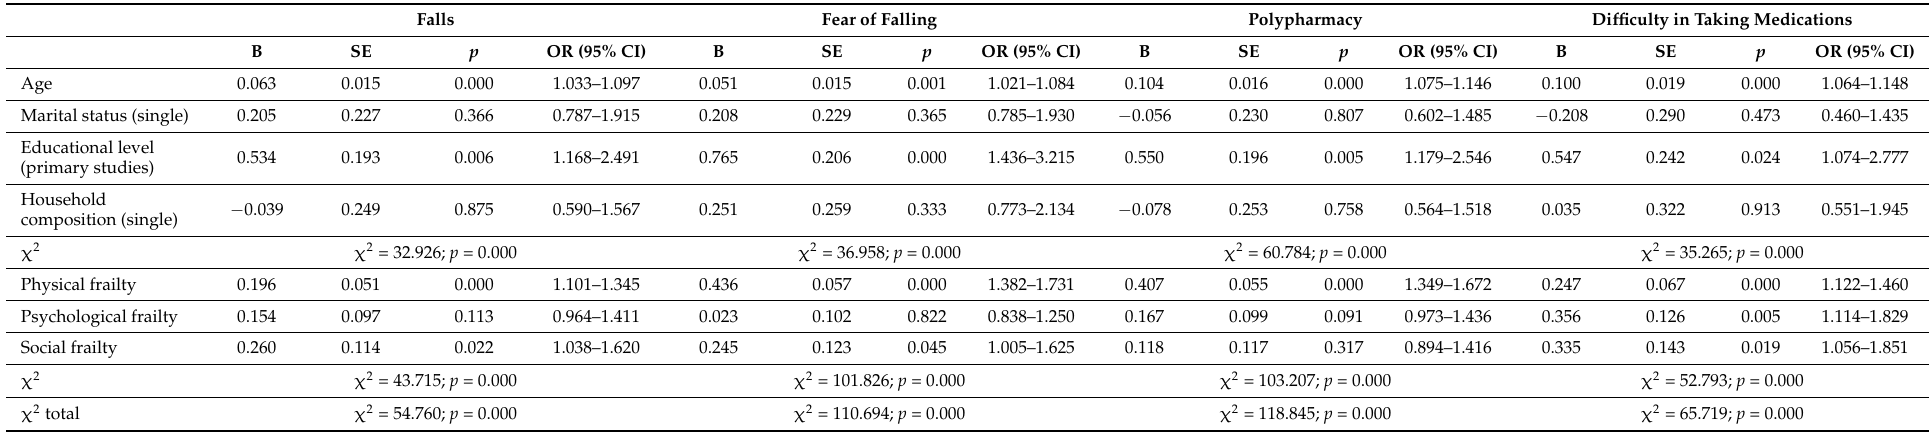
Table 4. CROSS-SECTIONAL Effects of Socio-demographic Characteristics and Frailty Domains on Adverse Outcomes: Logistic Regression